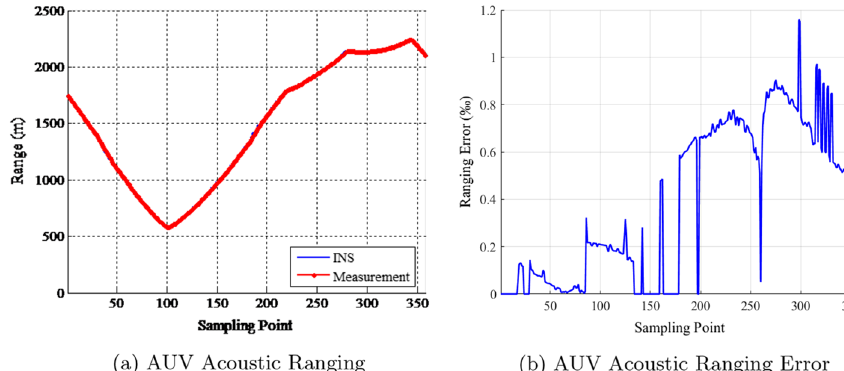
Fig. 11 AUV acoustic ranging and acoustic ranging error data